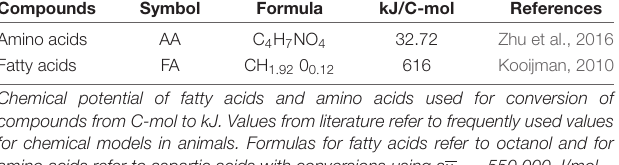
Light parameters obtained during the parametrization of the two models scenarios using the fix standards parameters shown in Supplementary Table B.2 .